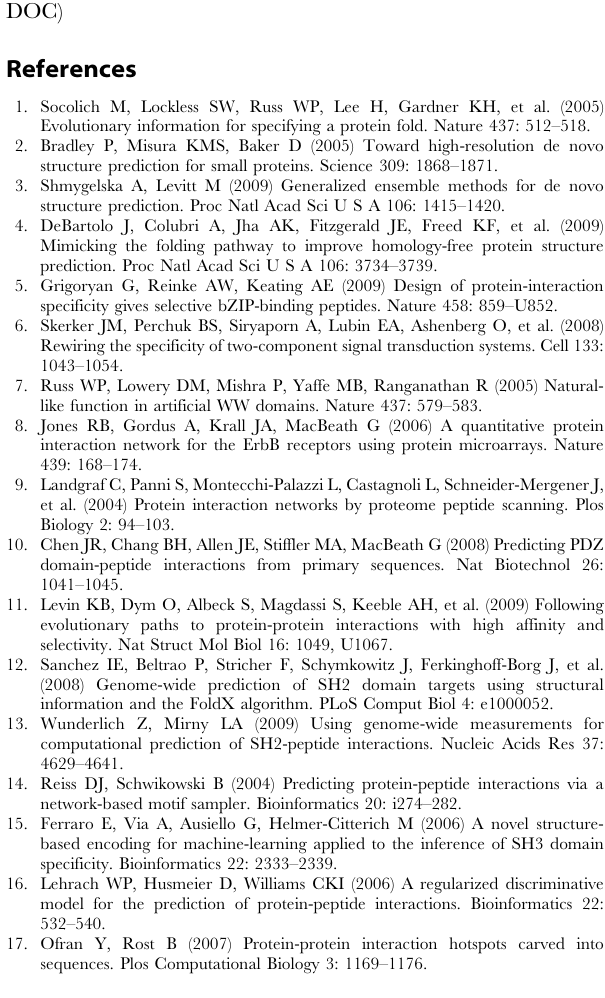
Table S5 Mutagenesis positions.